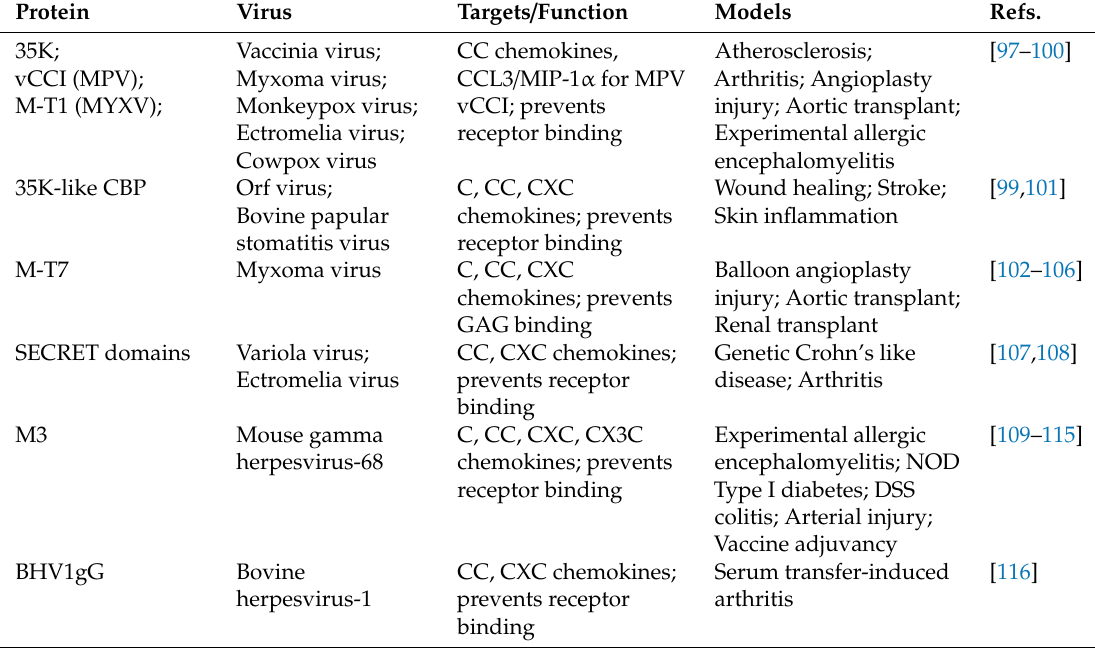
Table 2. Viral chemokine-modulating factors with therapeutic e ffi